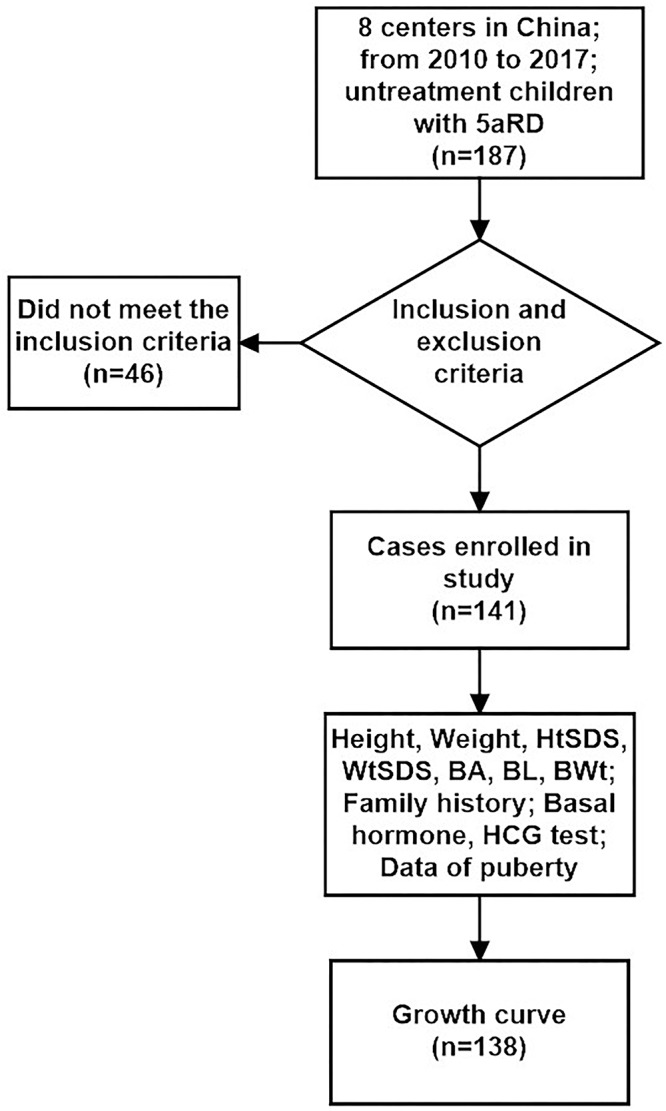
Flow chart of the study design.